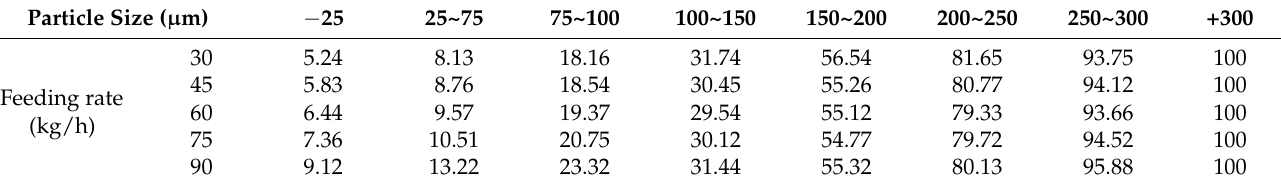
Table 5. Effect of the feeding speed on cumulative particle size